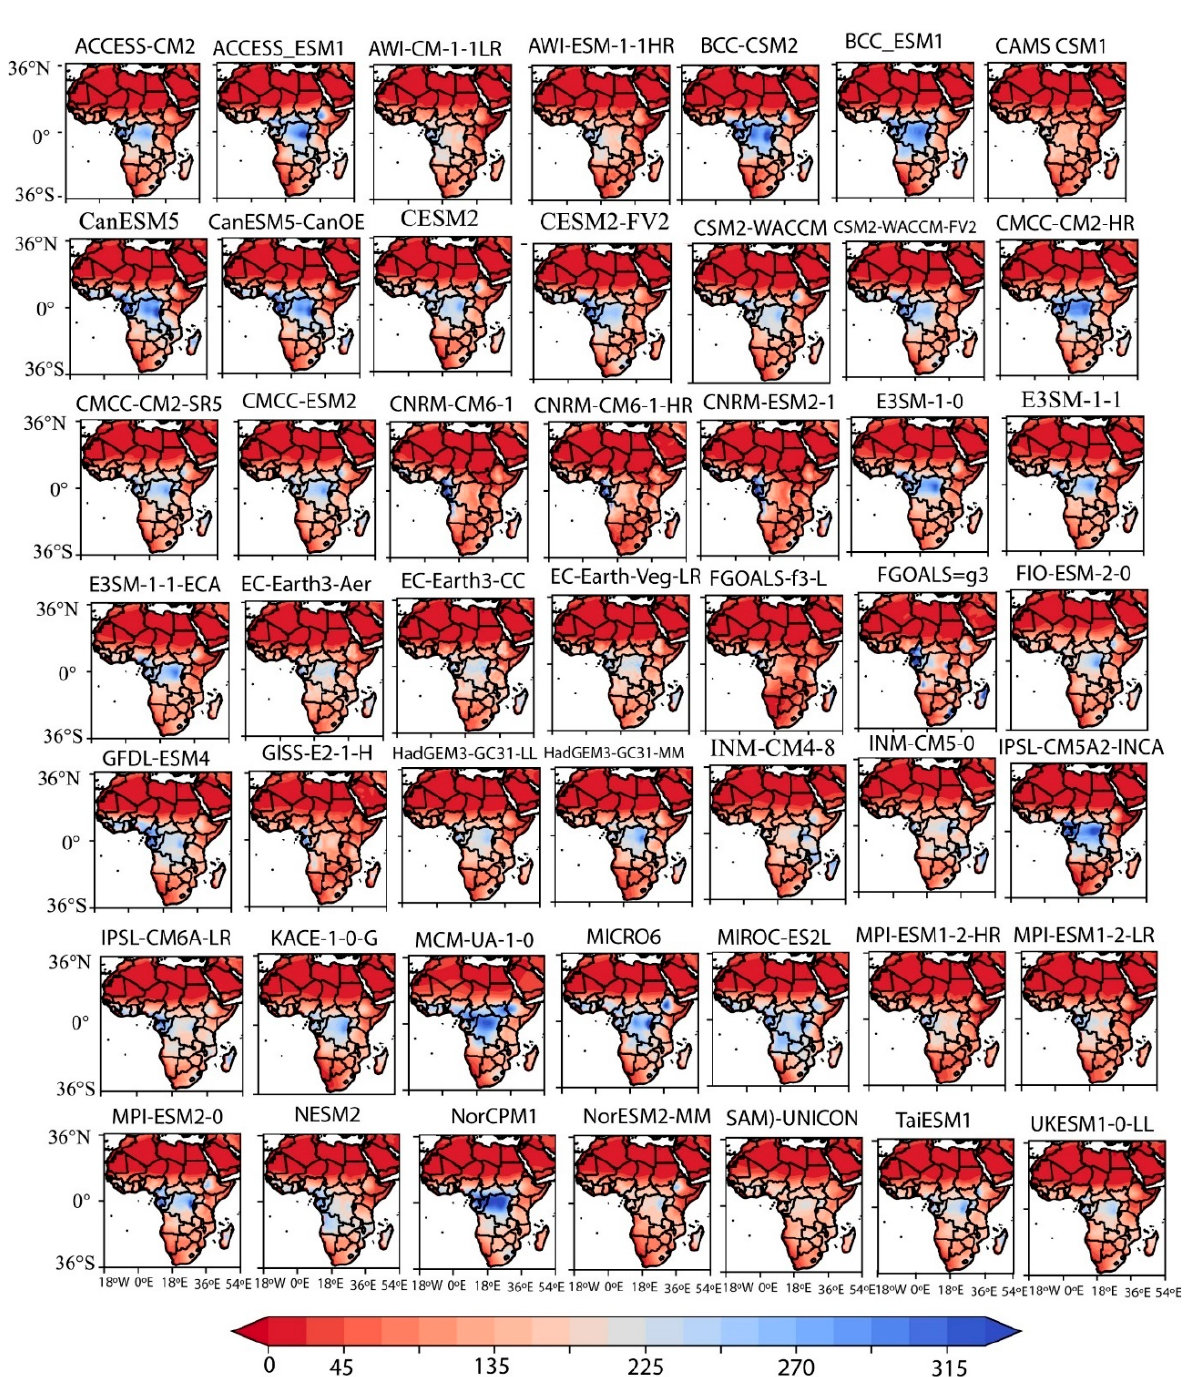
Figure 4. Spatial distribution of multi-year mean precipitation in 49 selected individual models. The unit is mm year − 1 .